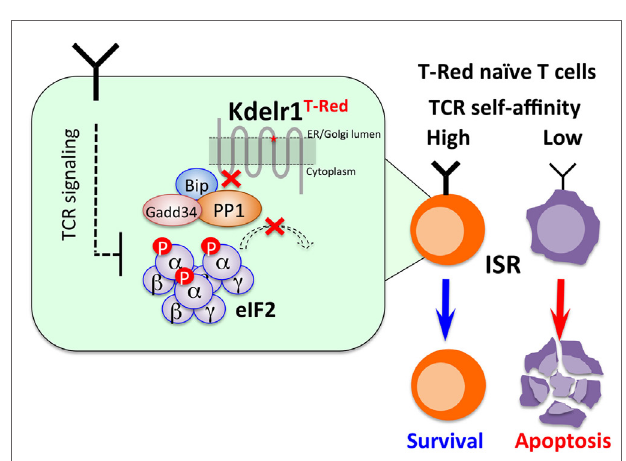
FiGURe 2 | Strong TCR-mediated signals alleviate iSR in T-Red naïve T cells . T-Red naïve T cells expressing TCR with relatively high self-affinity are resistant to enhanced ISR caused by Kdelr1 dysfunction. Further studies are required to reveal the specific TCR signaling that counteracts ISR.